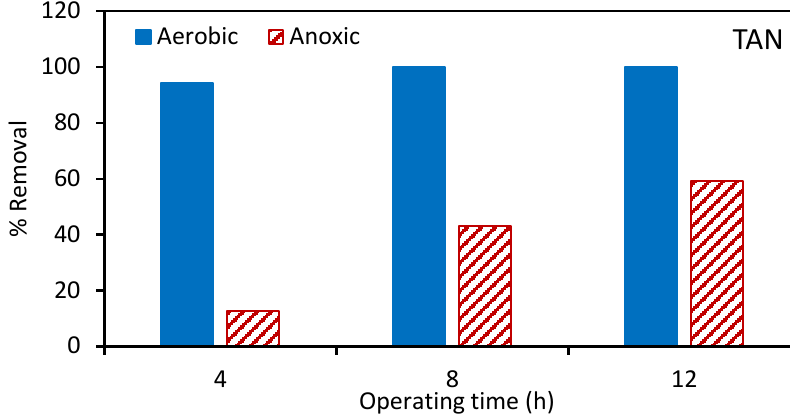
Figure 2. Percentage removal of chemical oxygen demand (COD) in the aerobic and anoxic tanks at 4, 8, and 12 h after spiking with atrazine. The total suspended solids (TSS) for the aerobic and anoxic tanks was 7029 and 6024 ± 600 mg/L, respectively.